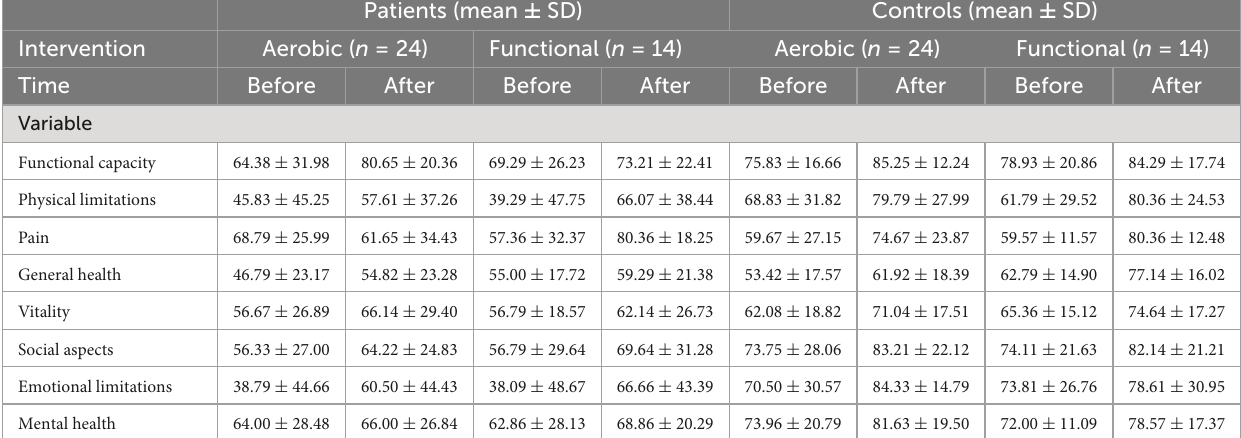
TABLE 3 Assessment of quality of life by SF-36 before and after intervention between cases and controls according to intervention.